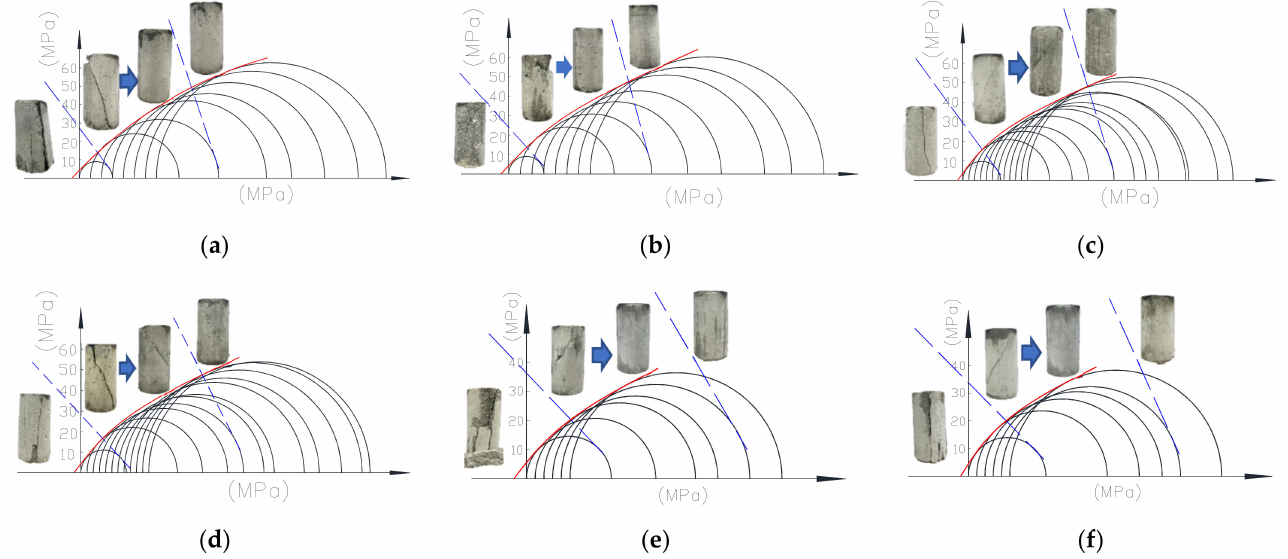
Figure 12. Mohr–Coulomb stress envelope for LAC. ( a ) LAC20, soak for 1 h; ( b ) LAC20, soak for 12 h; ( c ) LAC30, soak for 1 h; ( d ) LAC30, soak for 12 h; ( e ) LAC40, soak for 1 h; ( f ) LAC40, soak for 12